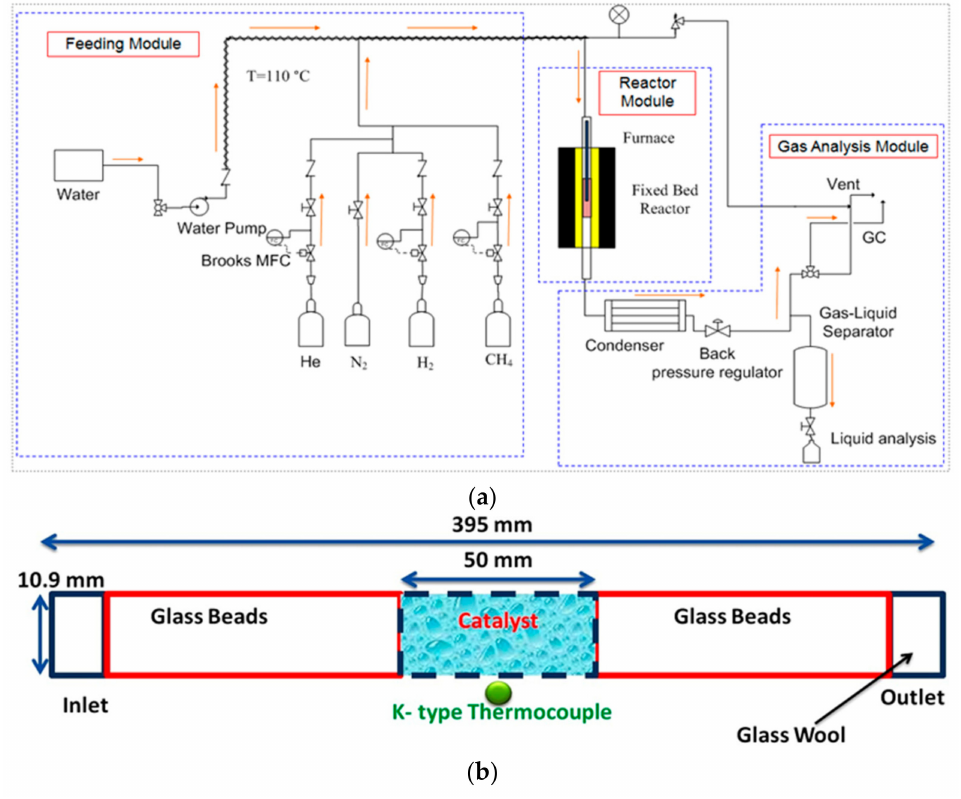
Figure 1. Experimental test rig: ( a ) flow sheet diagram for methane steam reforming activity test and ( b ) fixed bed tube